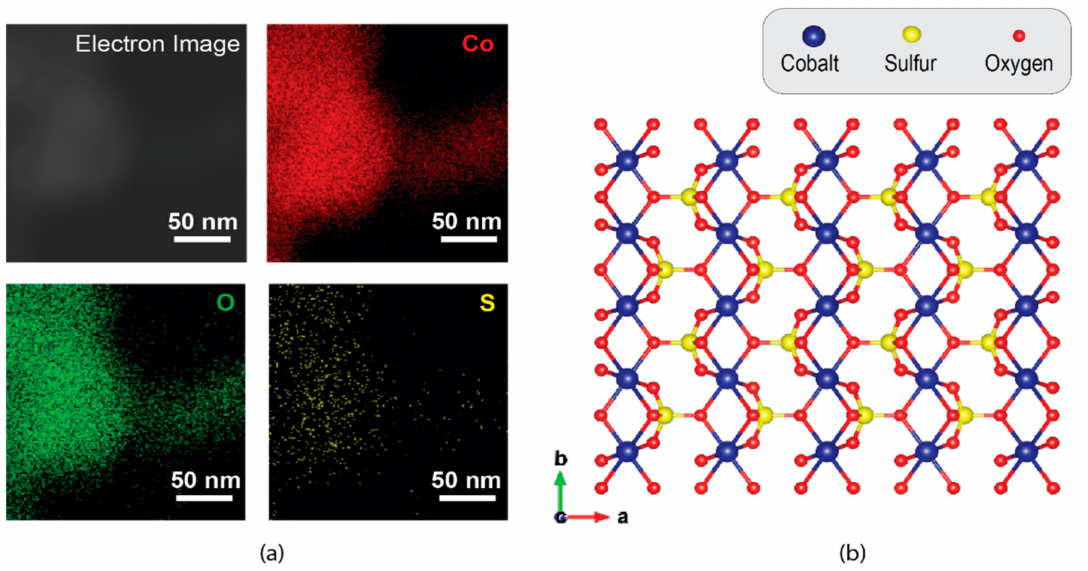
Figure 2. ( a ) Elemental analysis of cobalt oxysulfide on EDS. ( b ) The theoretical crystal model of cobalt oxysulfide (based on VESTA